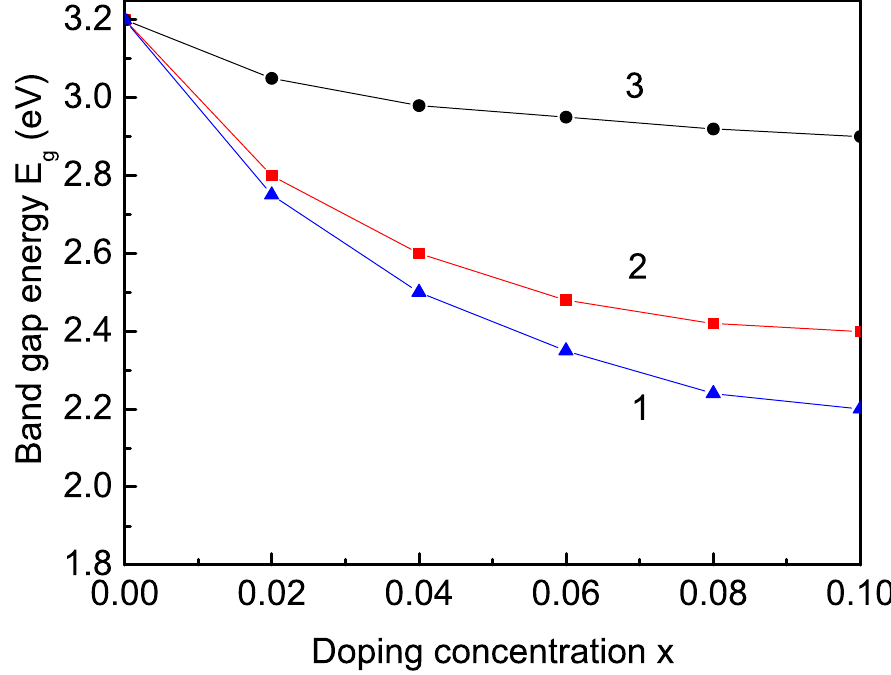
Figure 6. Dependence of the band-gap energy E g on the doping concentration x in bulk TiO 2 : (1) Co, (2) Fe, and (3) Sm, for J s = 1.2 J b , T = 300